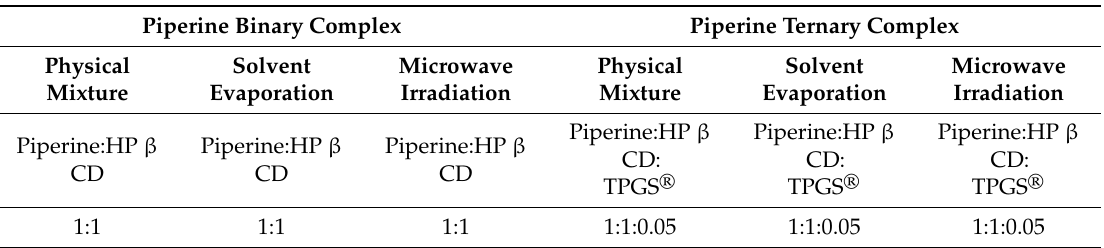
Table 1. Formulation design of piperine inclusion complex using di ff erent methods ( w / w ). Piperine Binary Complex Piperine Ternary